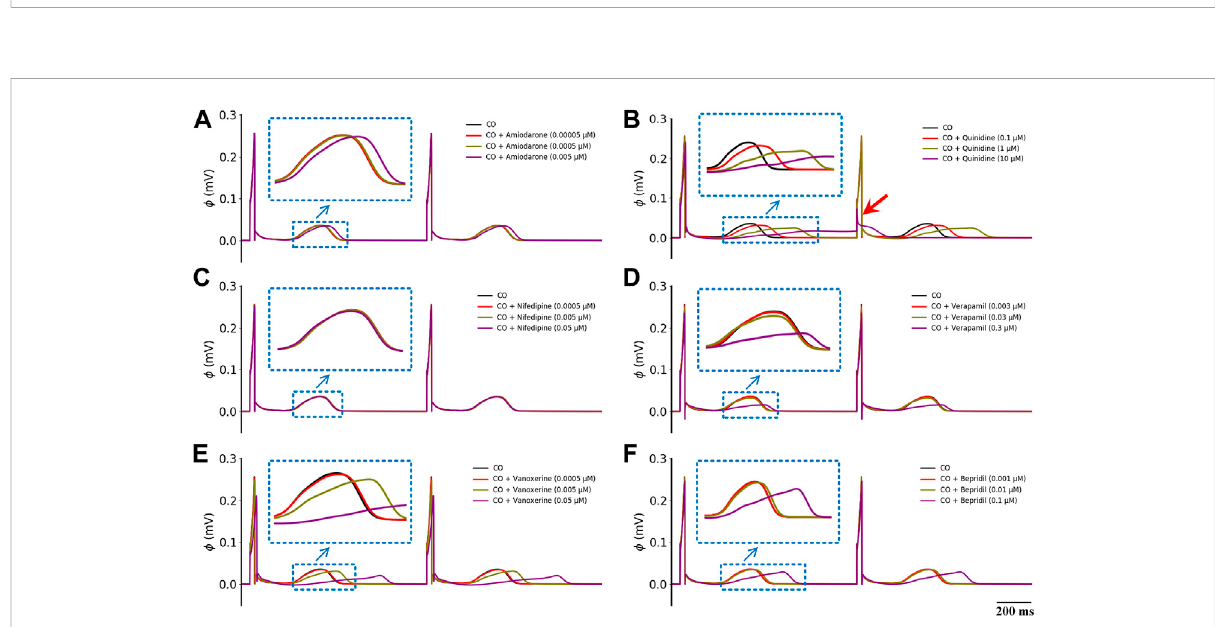
FIGURE 5 Effectsofsixmulti-channelblockersatthreedosesonECGmorphologyunderhealthyconditions. (A) amiodarone, (B) quinidine, (C) nifedipine, (D) verapamil, (E) vanoxerine and (F) bepridil. Blue ‘ ↓ ’ indicates the magni fi cation of the rectangular area; red ‘ ↓ ’ indicates the failed depolarization in